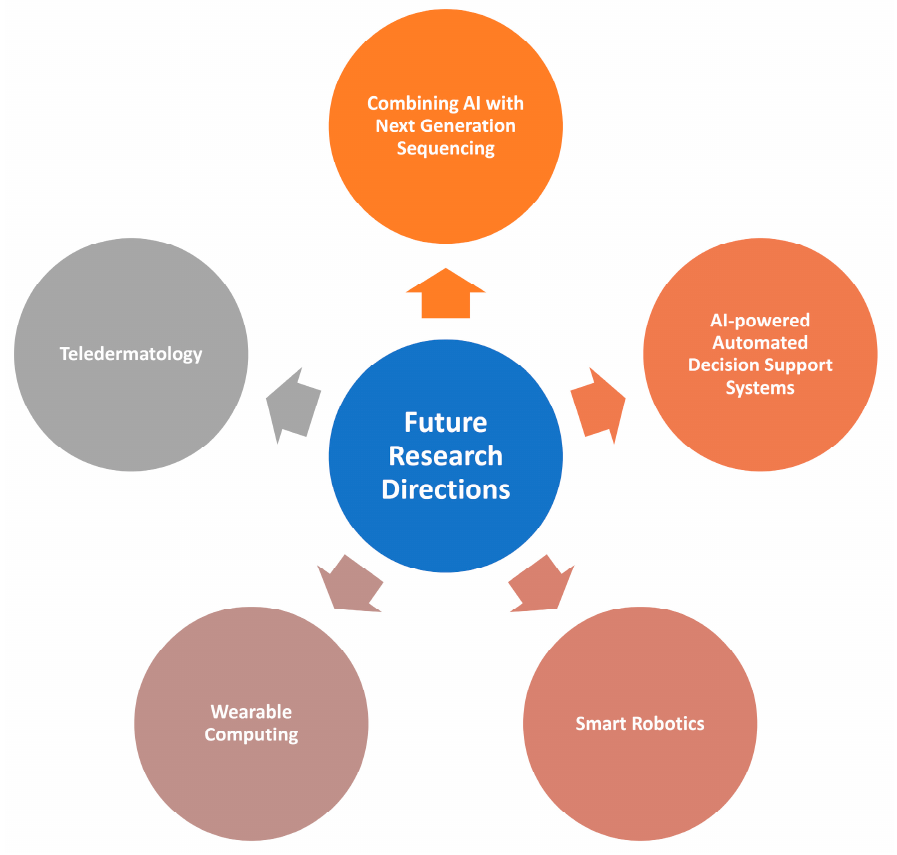
Figure 10. Future research directions of skin cancer diagnosis.